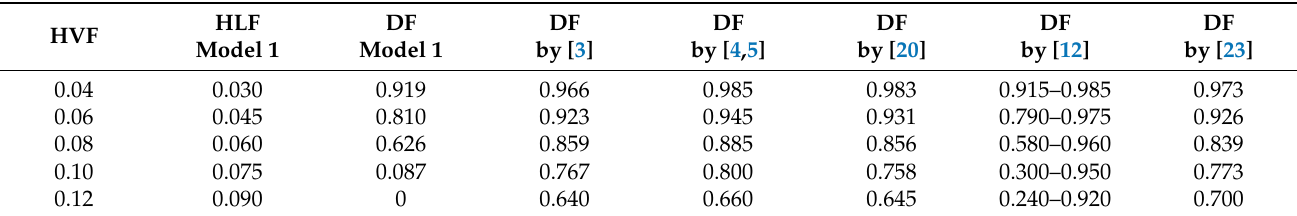
Table 3. Comparison of DF